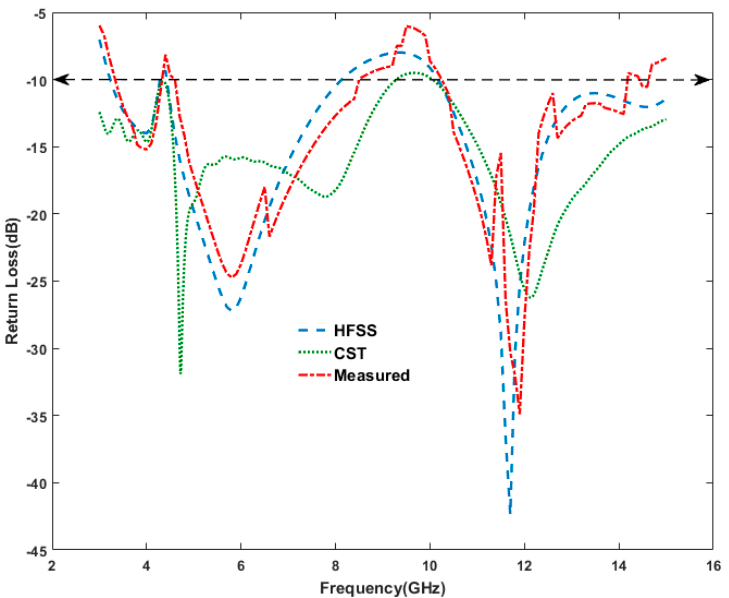
Figure 9. Simulated and measured return loss performance.